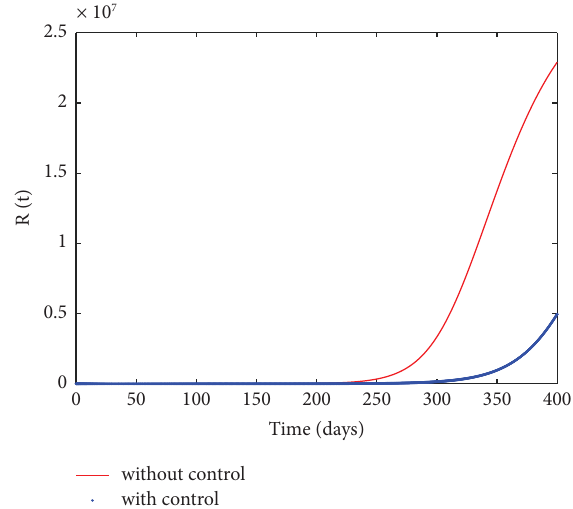
Figure 15: Behaviour of the recovered individuals with and without the